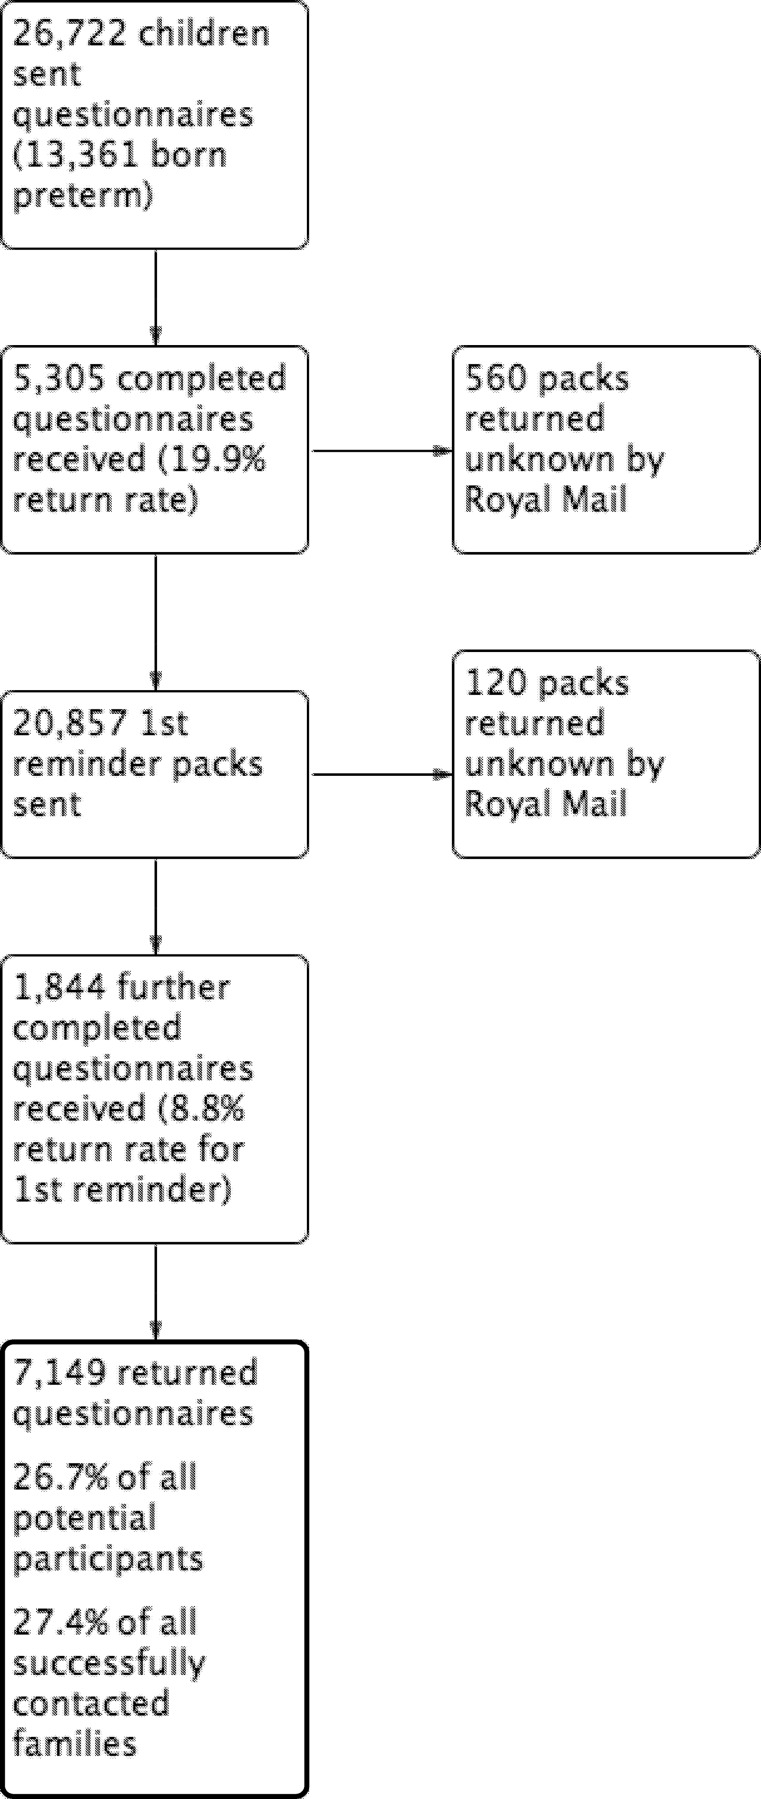
Diagram showing return rates of completed questionnaires in the Respiratory and Neurological Outcomes of children born Preterm Study (RANOPS).